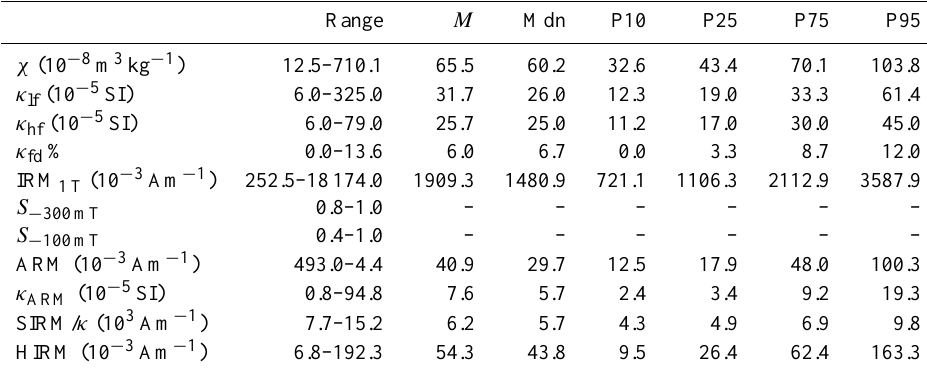
Table 2. Summary statistics of the magnetic measurements.